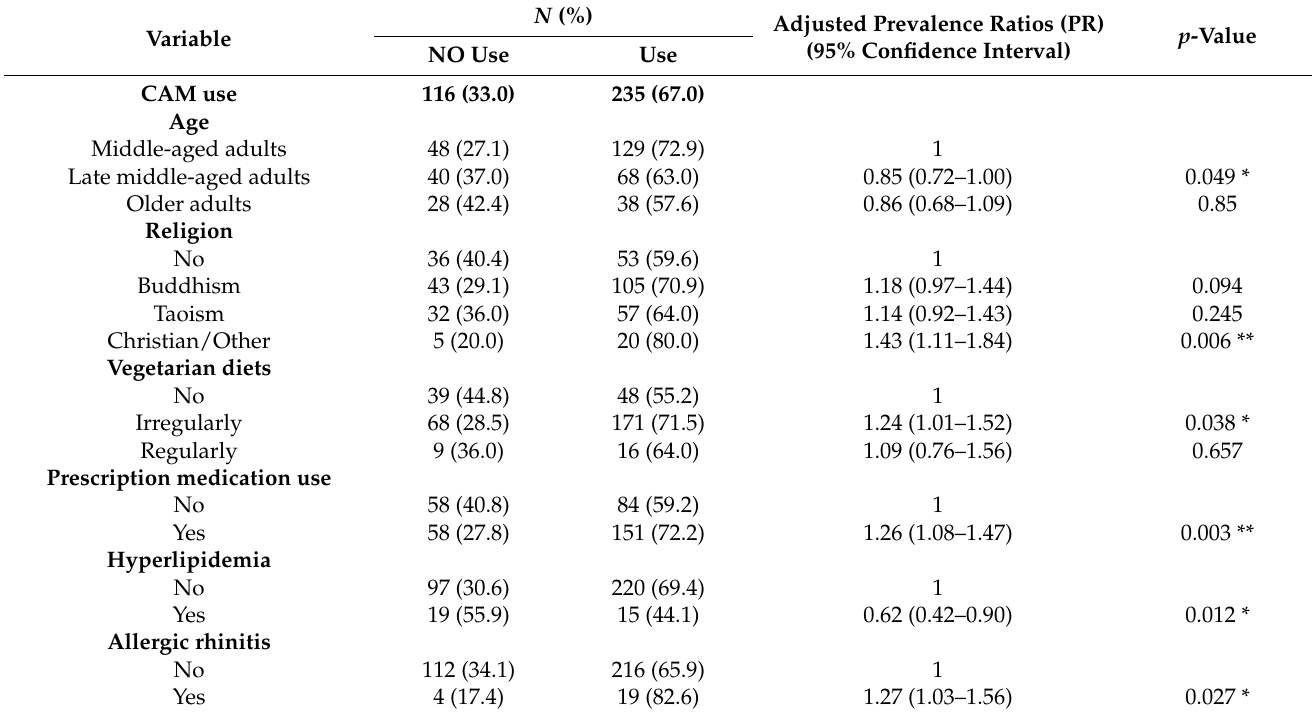
Table 4. The log-binomial regression analyses of demographic and clinical factors influencing the use of complementary and alternative medicines (CAMs) in study participants ( N =